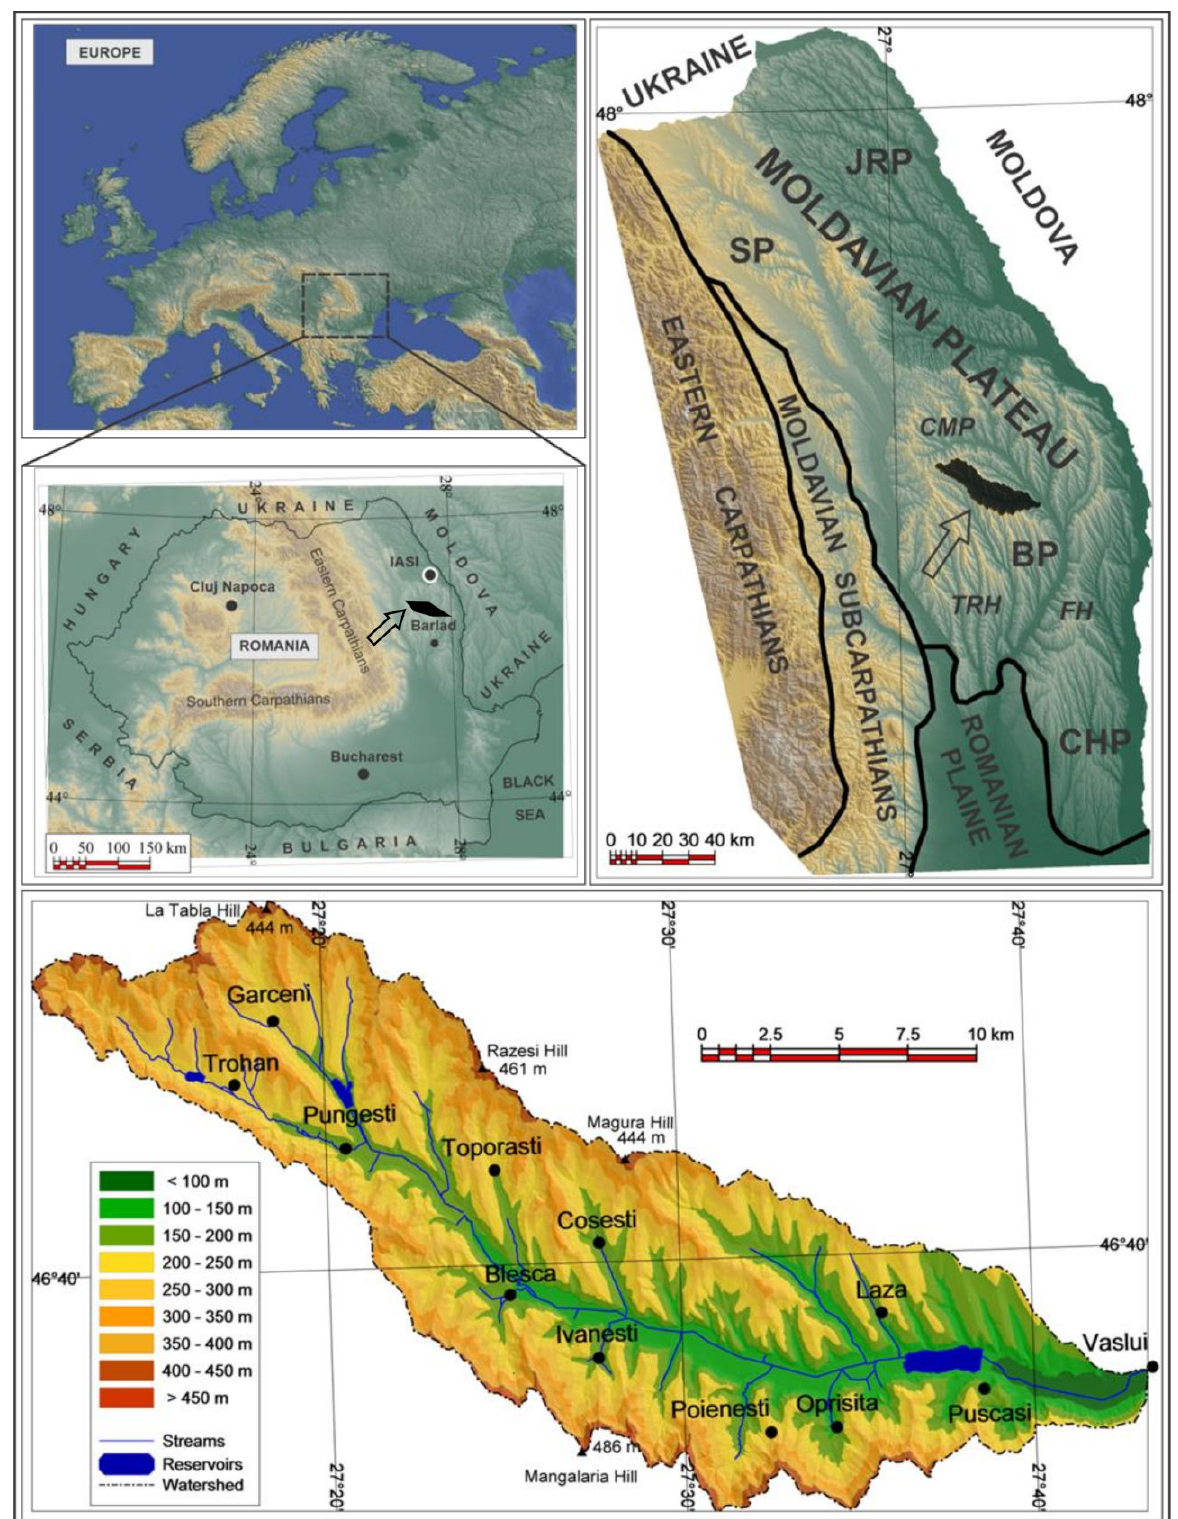
Figure 1. Location of the study